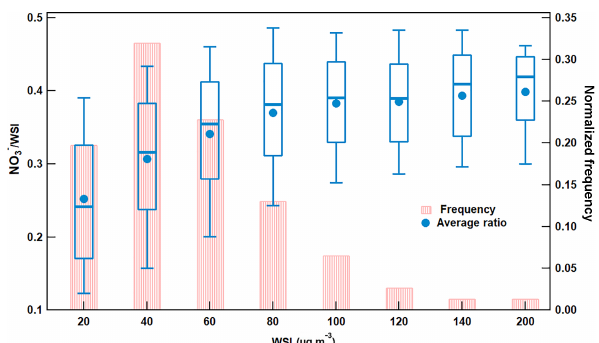
Figure 2. Average proportion of nitrate and normalized frequency of occurrence at different mass concentration bins of water-soluble ions at SORPES. For the ratio, box boundaries represent the in- terquartile range, bars represent 5%–95% percentile range and hor- izontal lines represent the median